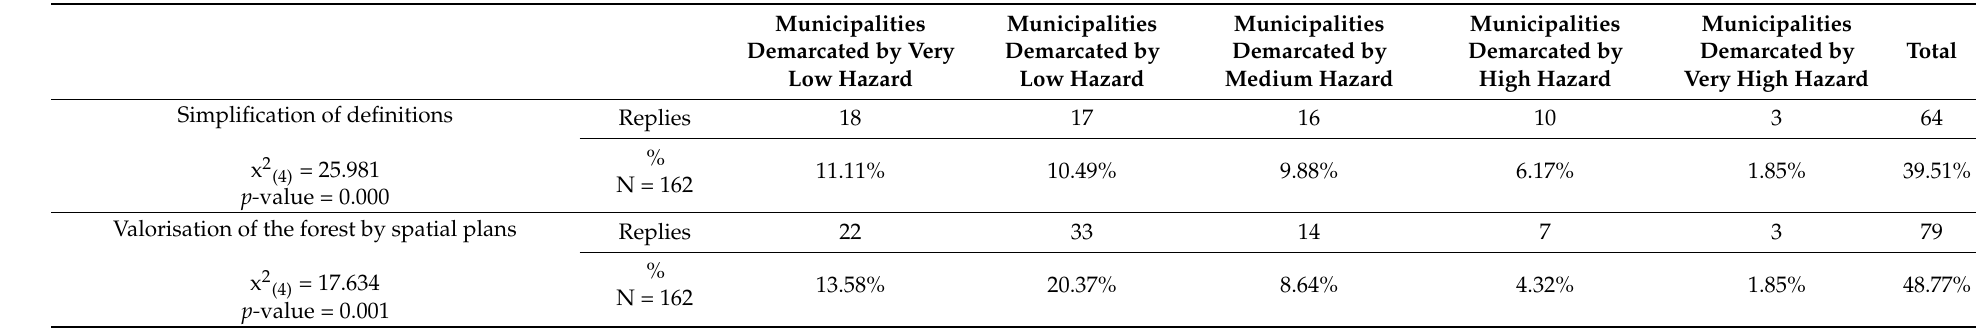
Table 6. Relationships with statistical significance established between the considered opportunity of simplification of definitions and valorisation of the forest capital by spatial plans , and the influence of wildfire hazard in municipalities.